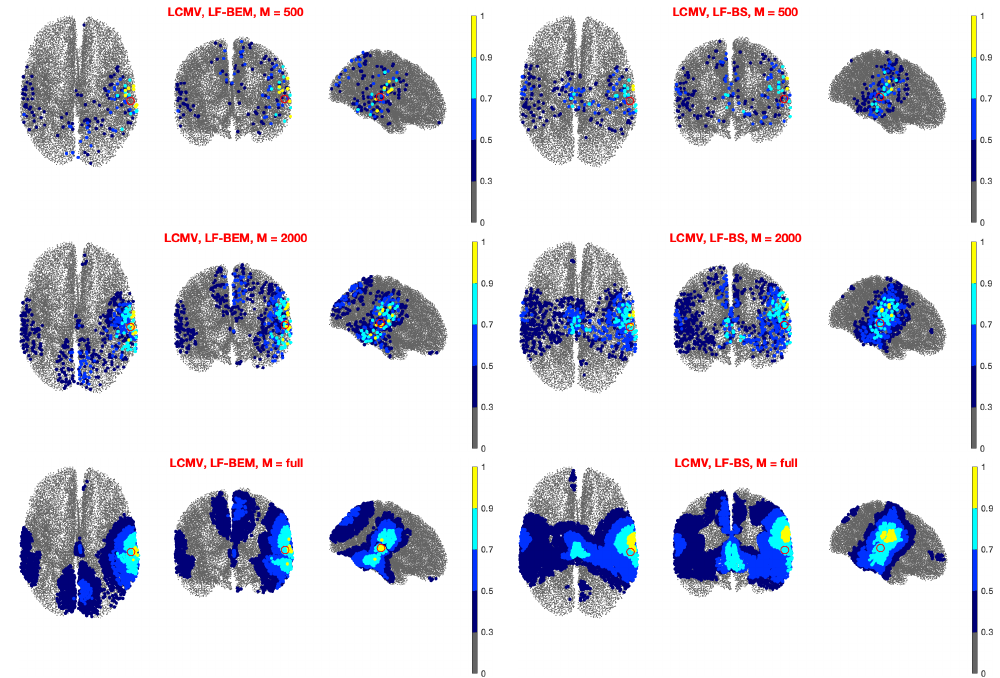
Figure 9. Left Auditory evoked field: The intensity of the estimated sources, averaged over N = 10 runs, at 90 ms obtained using LCMV with M = 500 random points (first row), M = 2000 (second row) and the full source space (third row) for LF-BEM (left column) and LF-BS (right column). The red circle represents the dipole fitted using